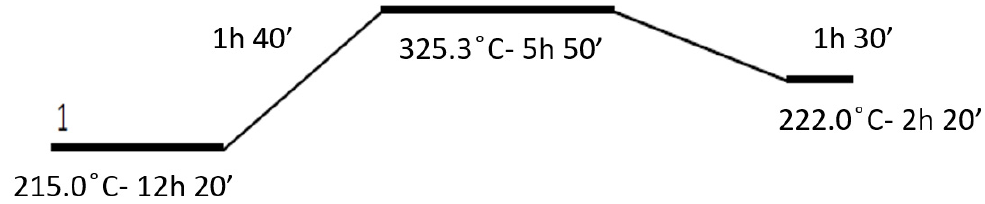
Figure 7. Thermal cycle for sample aging.